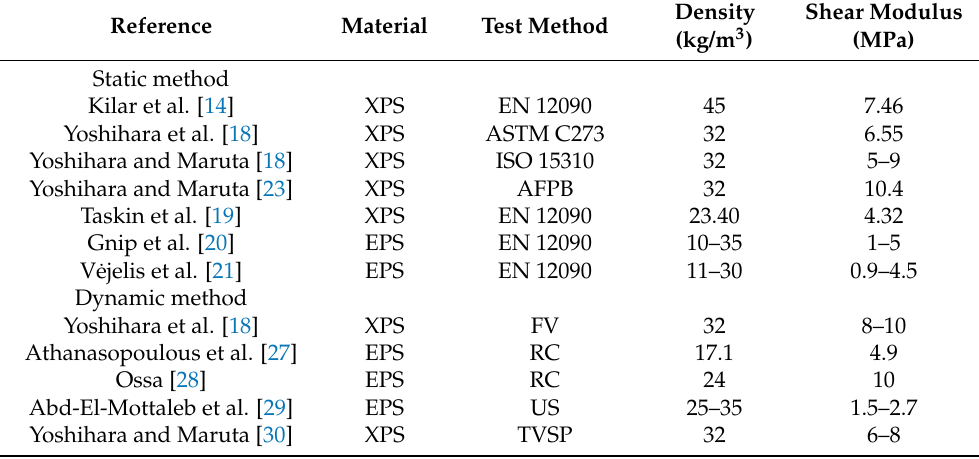
Table 1. Shear modulus of XPS and EPS obtained by various methods referred from previous